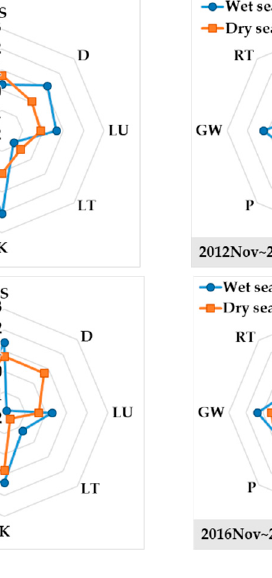
Figure 13. The estimated weighting coefficients in the wet and dry seasons for different years.